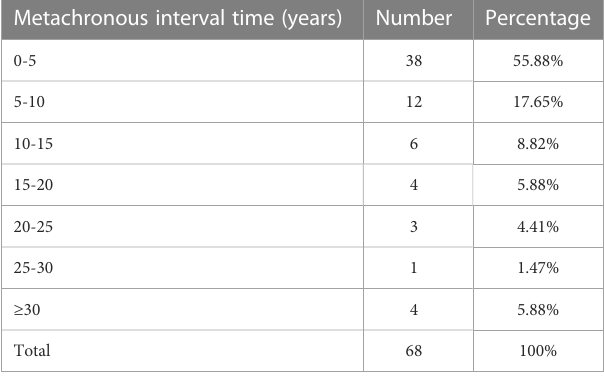
TABLE 3 Average interval time for different cancer types to develop second primary breast carcinoma. Metachronous interval time